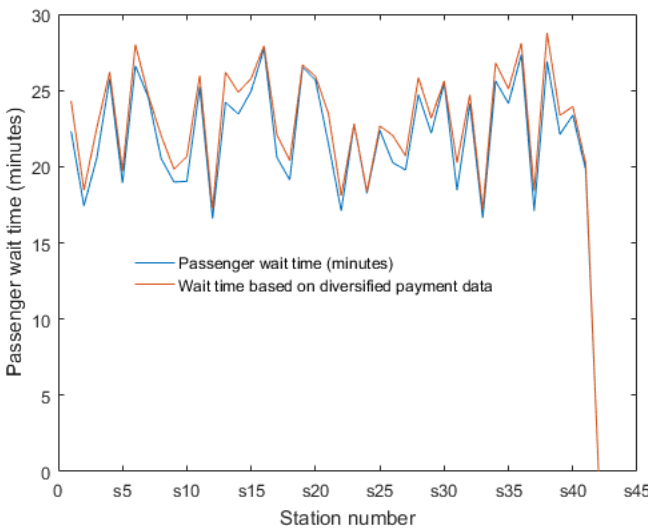
Figure 10. Comparison of passenger wait time